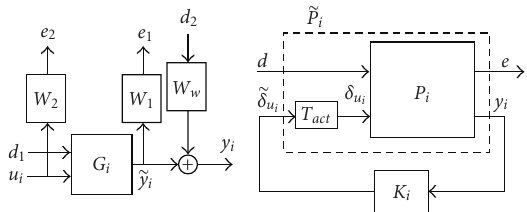
Figure 3: Block interconnection making up the augmented plant (left) and Inclusion of low-pass transfer function model of actuator dynamics